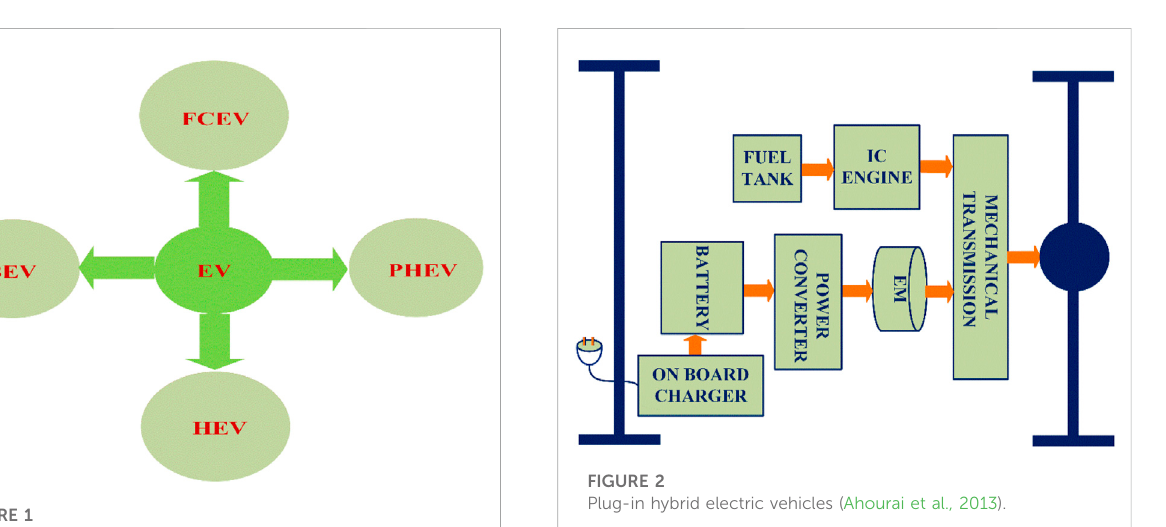
FIGURE 1 Classi fi cation of electric vehicles.